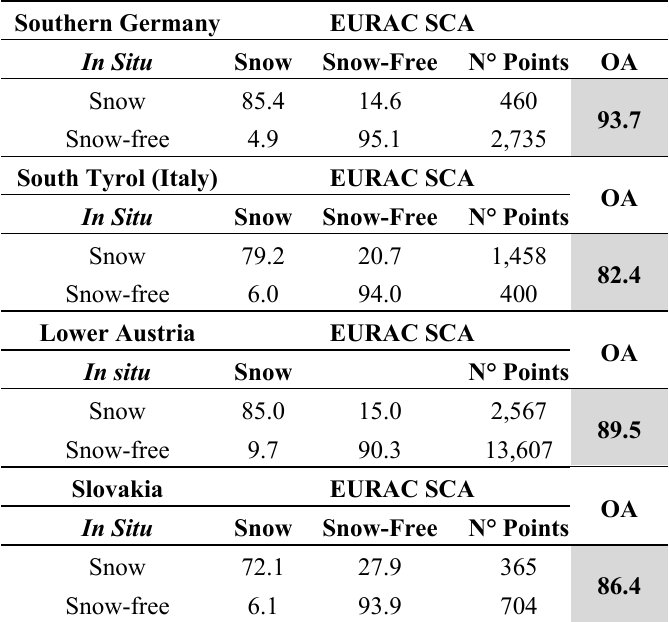
Table 5. Hit rates and overall accuracies (OA) of the EURAC snow cover maps (SCA) maps and in situ snow depth measurements for the investigated areas in 2005 and 2006.